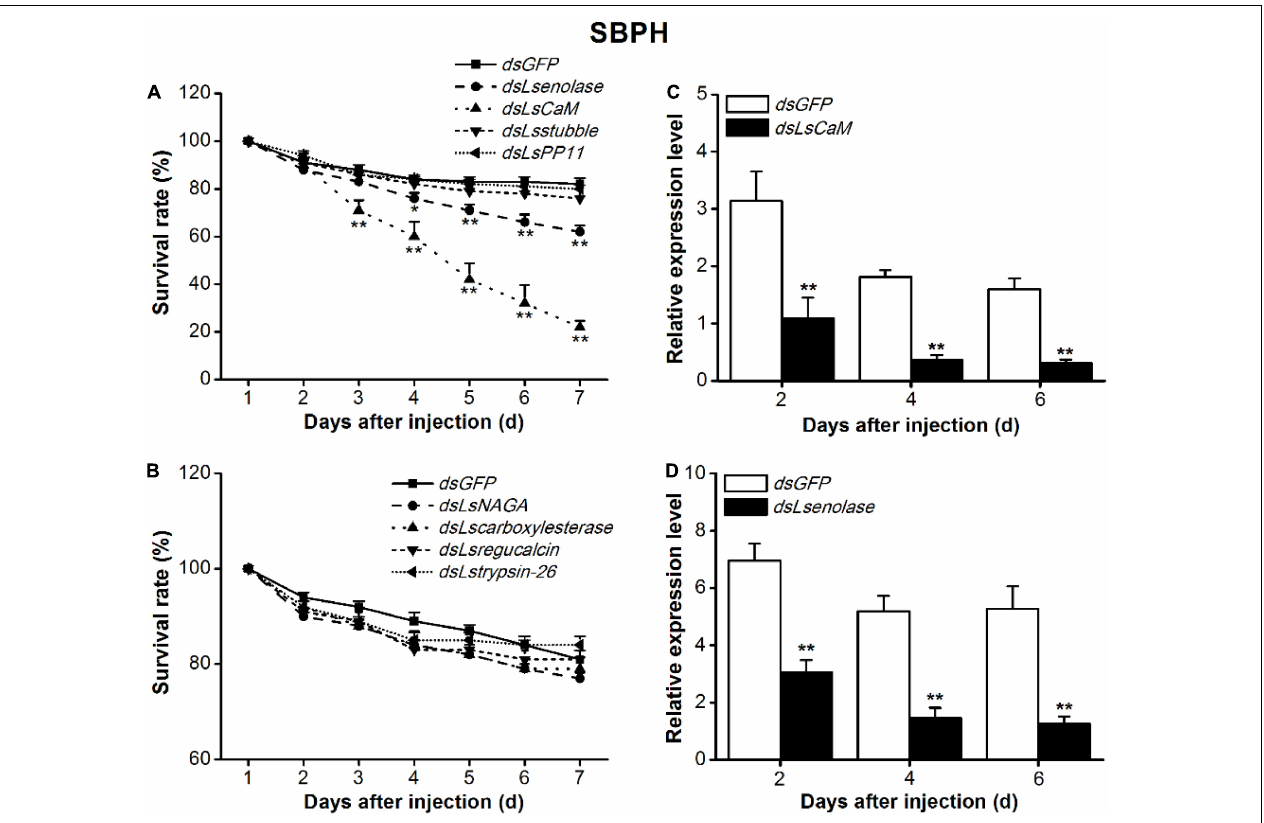
FIGURE 1 | Effects of silencing salivary protein-encoding genes on survival rates of SBPH on rice. (A,B) Mean survival rates + SE ( n = 5) of SBPH nymphs injected with dsRNA of indicated genes or GFP ( dsGFP ) at third-instar nymph stage. CaM, calmodulin; PP11, placental protein 11; NAGA, α - N -acetylgalactosaminidase. (C,D) Mean transcript levels + SE ( n = 3) of indicated target genes in SBPH injected with dsRNA of LsCaM ( dsLsCaM, C ), Lsenolase ( dsLsenolase , D ), or dsGFP . Asterisks indicate significant reduction in survival rates (A,B) and gene expression levels (C,D) of SBPH injected with dsLsCaM or dsLsenolase compared with those injected with dsGFP (* P < 0.05, ** P < 0.01; Student’s t